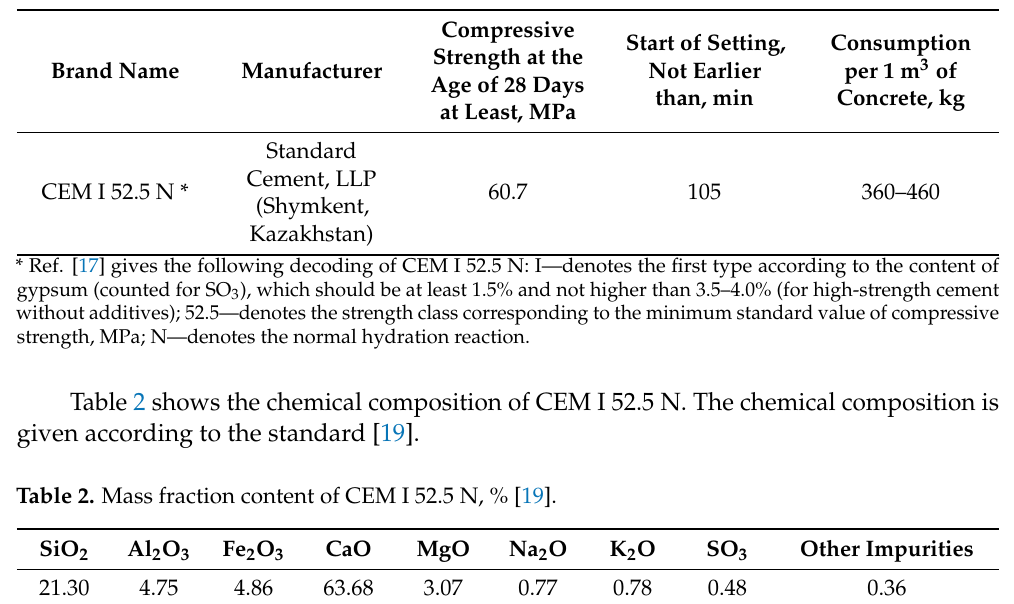
Table 1. Characteristics of cement [17,18].